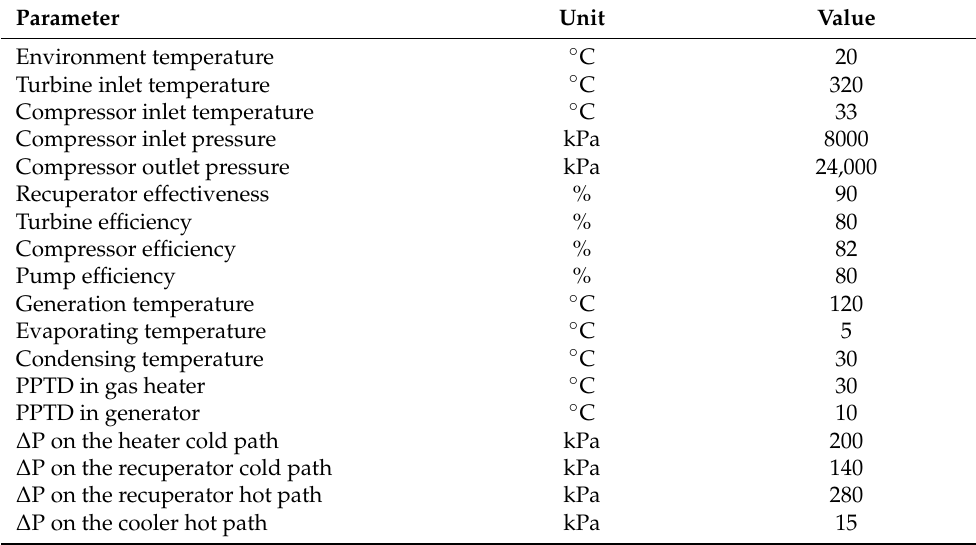
Table 4. Design parameters of the proposed WHR system